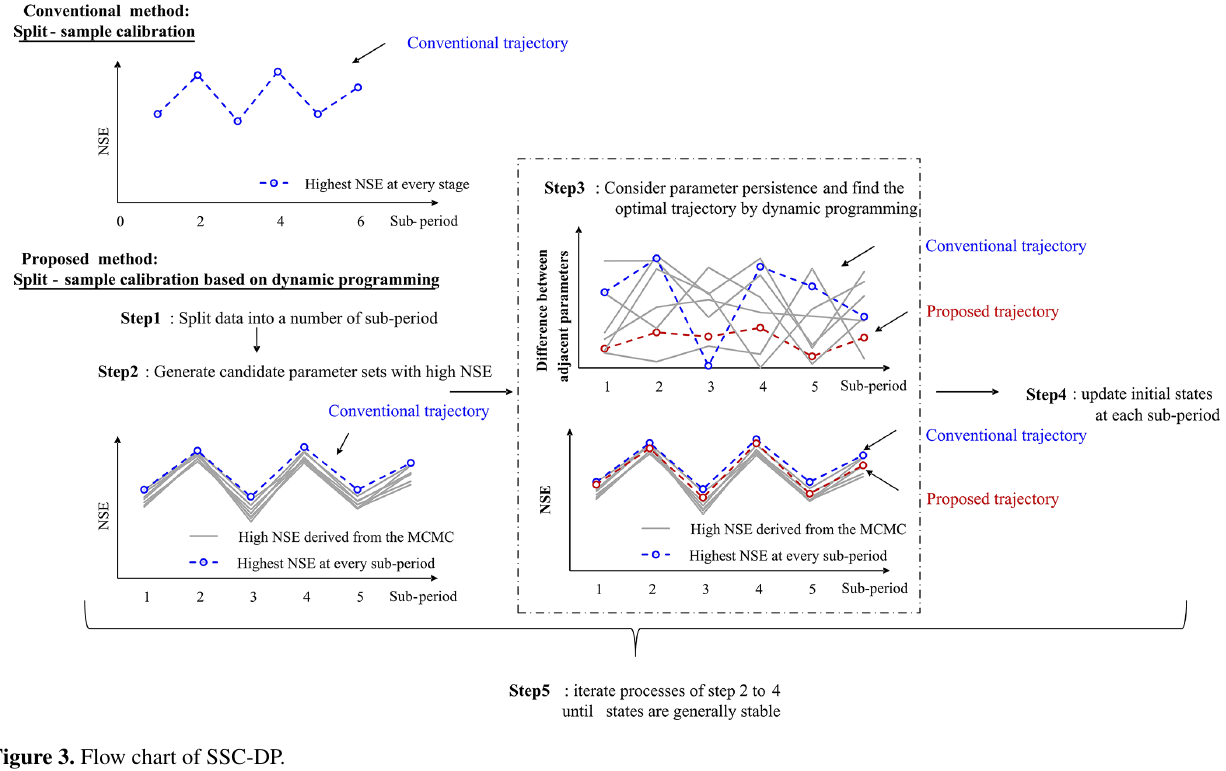
Figure 3. Flow chart of